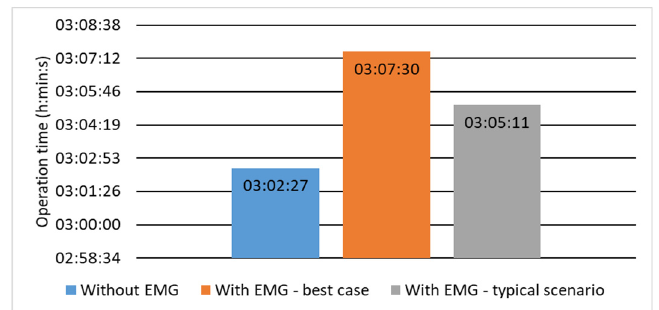
Figure 17. Active component operating time.